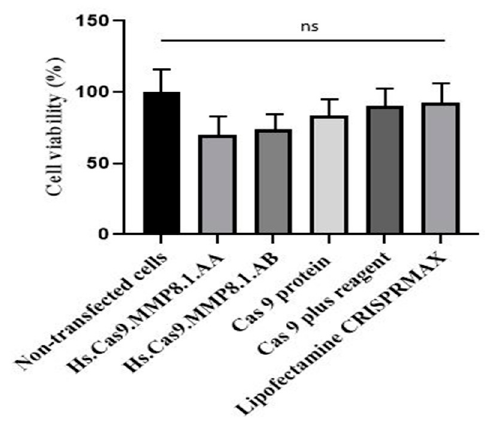
Figure 5. Cytotoxic effect of CRISPR/Cas 9 reaction components on A549 cells lines. Cells were treated with individual reaction components for 48 h and the cell viability was determined by MTT assay. The data were expressed as mean values ± Standard Error of the Mean (S.E.M) of viable cells ( n = 9).